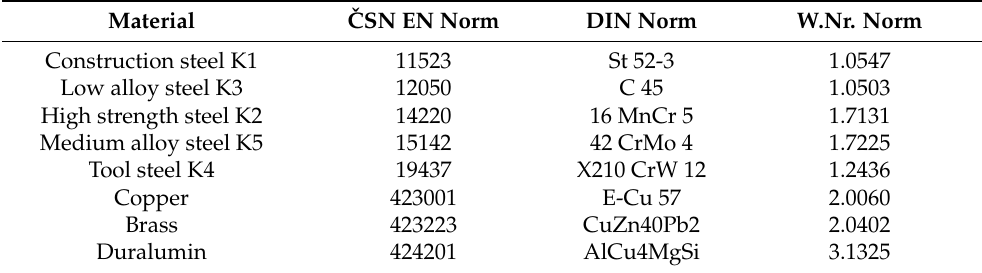
Table 1. Studied materials—summary of marking according to all norms used in previous published studies [41–44].